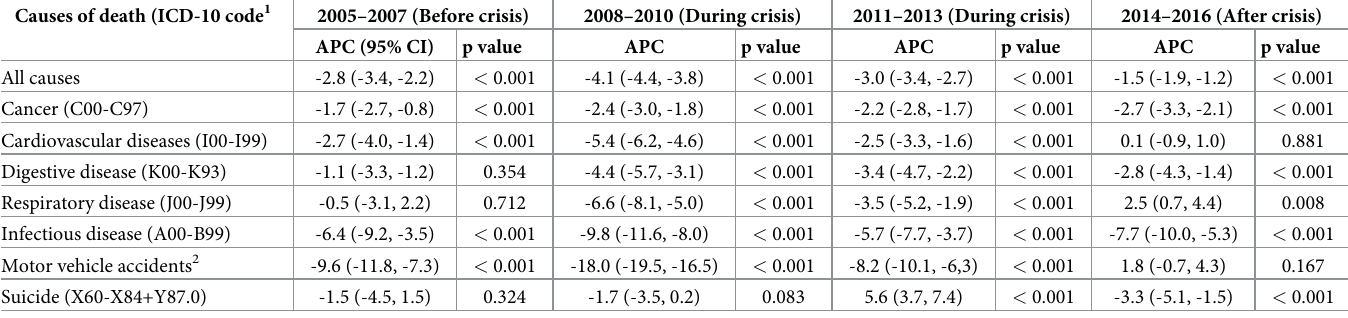
Table 3. Time trends in mortality rates by cause of death, before, during and after the 2008 economic crisis, in the Spanish men aged 15 to 64 years. Annual Percent- age Change (APC), 95% confidence interval (95% CI) and p value.